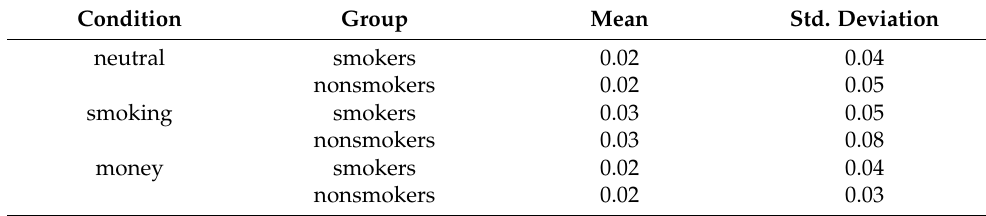
Figure 3. Mean reaction time (RT) for both smoker and nonsmoker groups across the neutral, smoking, and money conditions. Error bars indicate +/ − 2 standard errors from the mean. Table 3. Proportion of omissions in go trials for smokers and nonsmokers in the neutral, smoking, and money